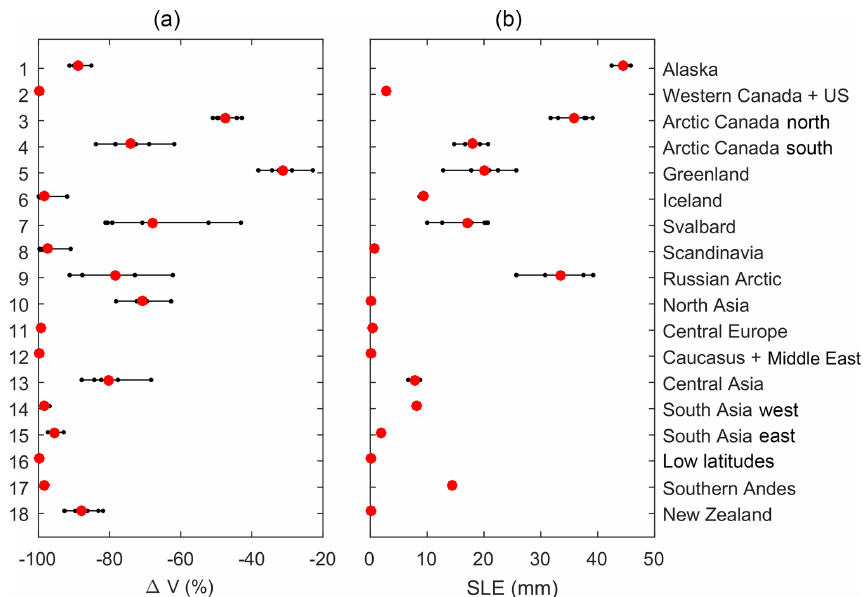
Figure 10. (a) Regional percentage volume losses at the end of the century (2097), relative to the initial volume and (b) volume losses expressed in sea level equivalent contributions. The large red dots represent the multi-model mean and the small black dots are the individual HadGEM3-A model